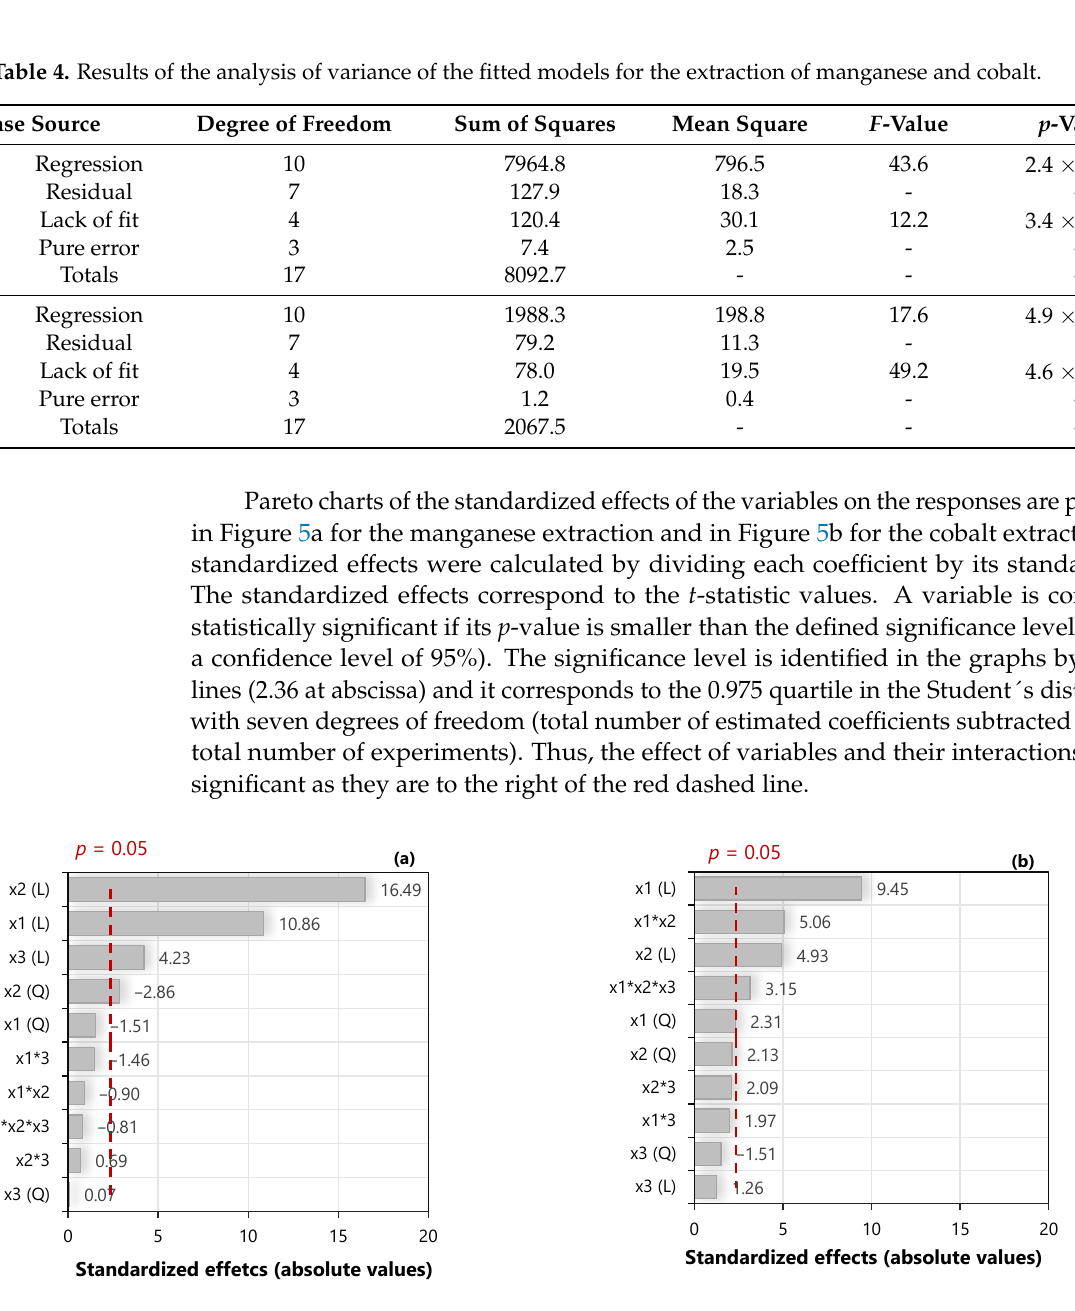
Figure 5. Pareto charts of the absolute values of the standardized effects of the factors for the regression model for ( a ) manganese extraction and ( b ) cobalt extraction with a significance level α = 0.05. Legend: x 1 : pH, x 2 : O:A ratio, x 3 : molar concentration of D2EHPA, (Q): quadratic terms, (L): linear terms.